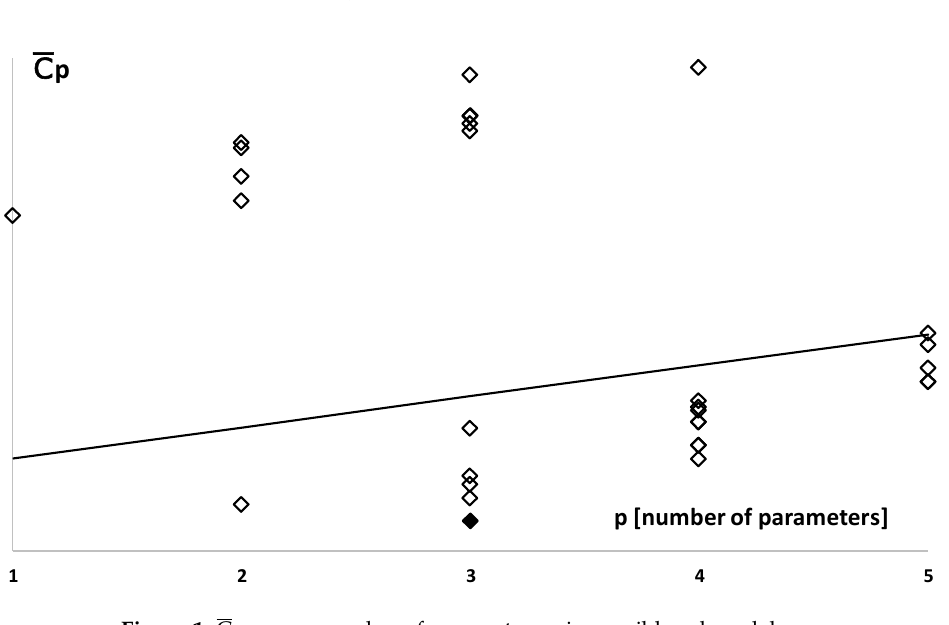
Figure 1. C p versus number of parameters p in possible submodels. Figure 1. C(cid:3364) p versus number of parameters p in possible submodels. Figure 1. C(cid:3364) p versus number of parameters p in possible submodels.